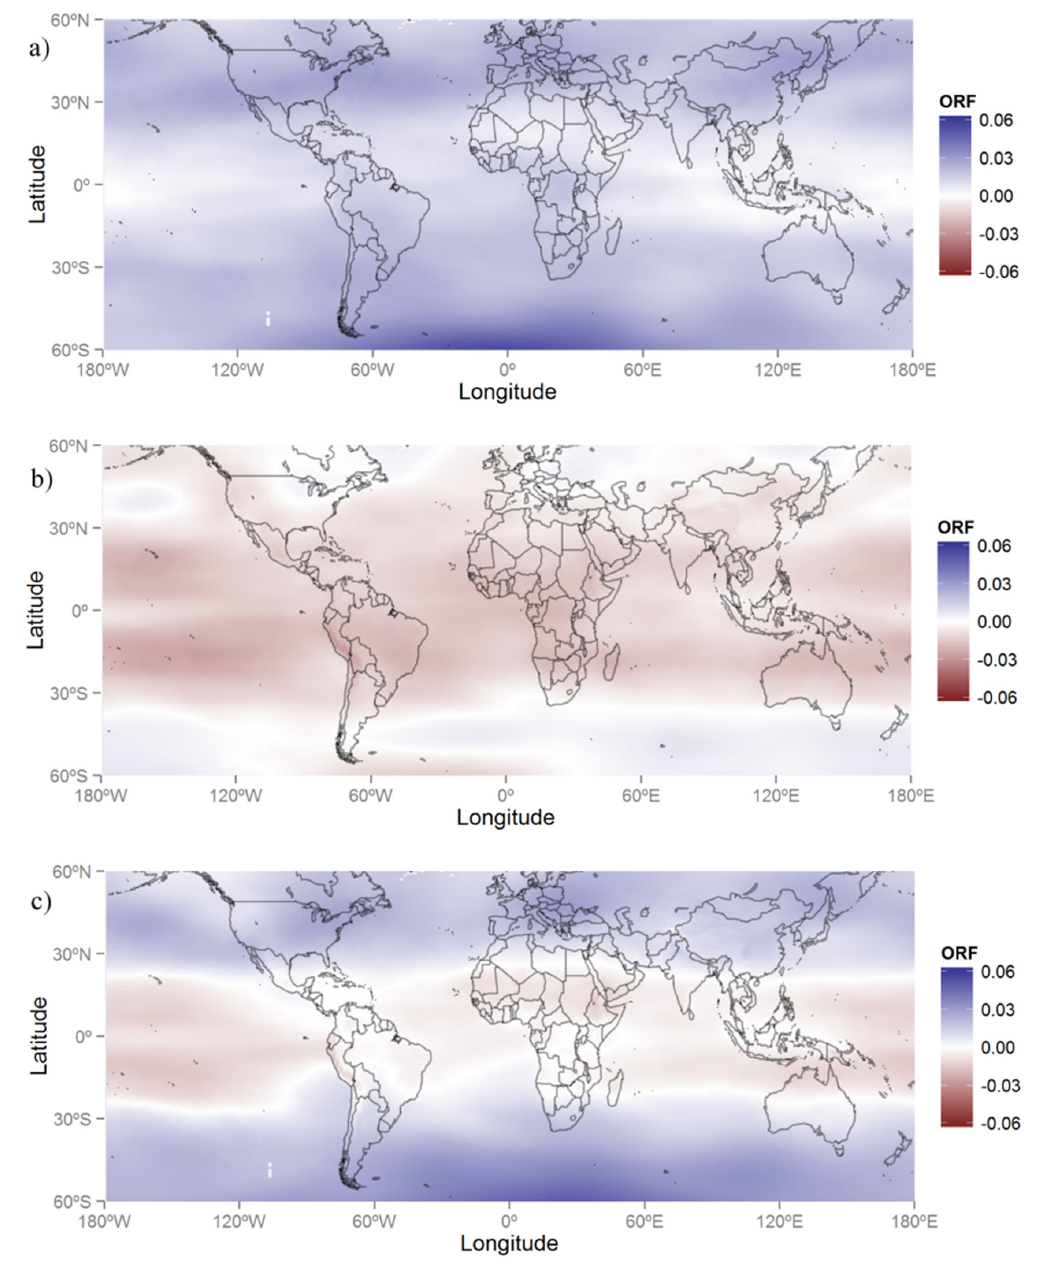
− 2 ) for three di ff erent periods: ( a ) ORF